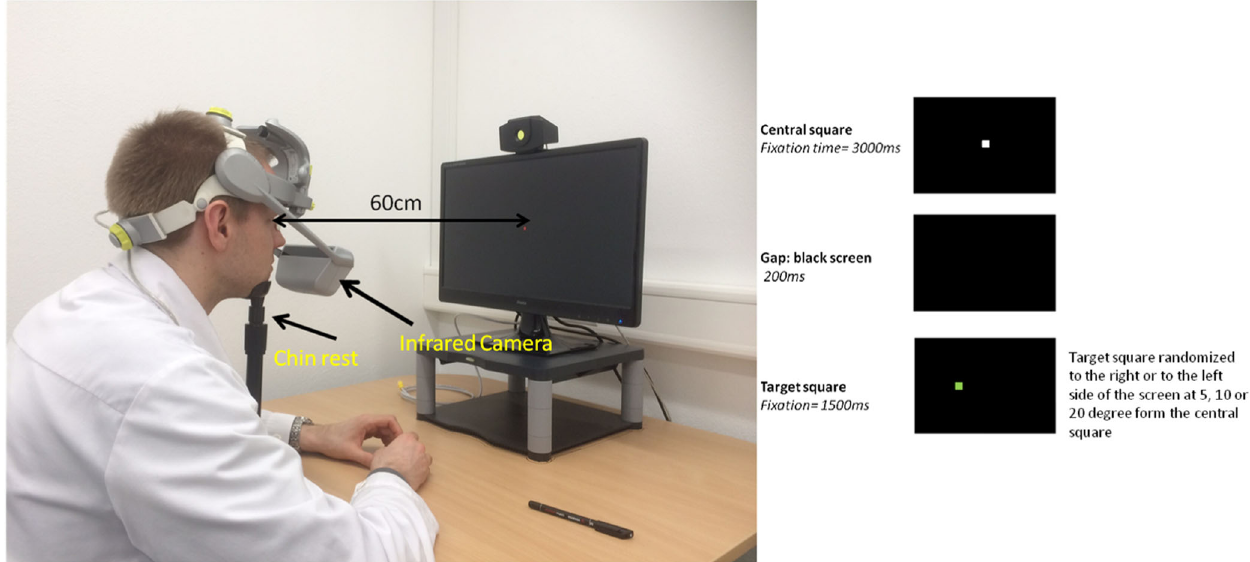
Fig. 1 Eye-tracker montage and sequence of events during a given trial. The sequence of events was identical on the prosaccade and antisaccade trials. For prosaccades, the instruction was, “ Look as fast as you can to the target square when it appears and come back to the central point. ” On antisaccade trials, subjects were instructed, “ When the green square appears, please look as quickly and accurately as possible to the mirror-image location in the opposite direction. Try to make an eye movement toward the target. ” The individual on this fi gure is a co-author (M, B). He has given his consent for the publication of his